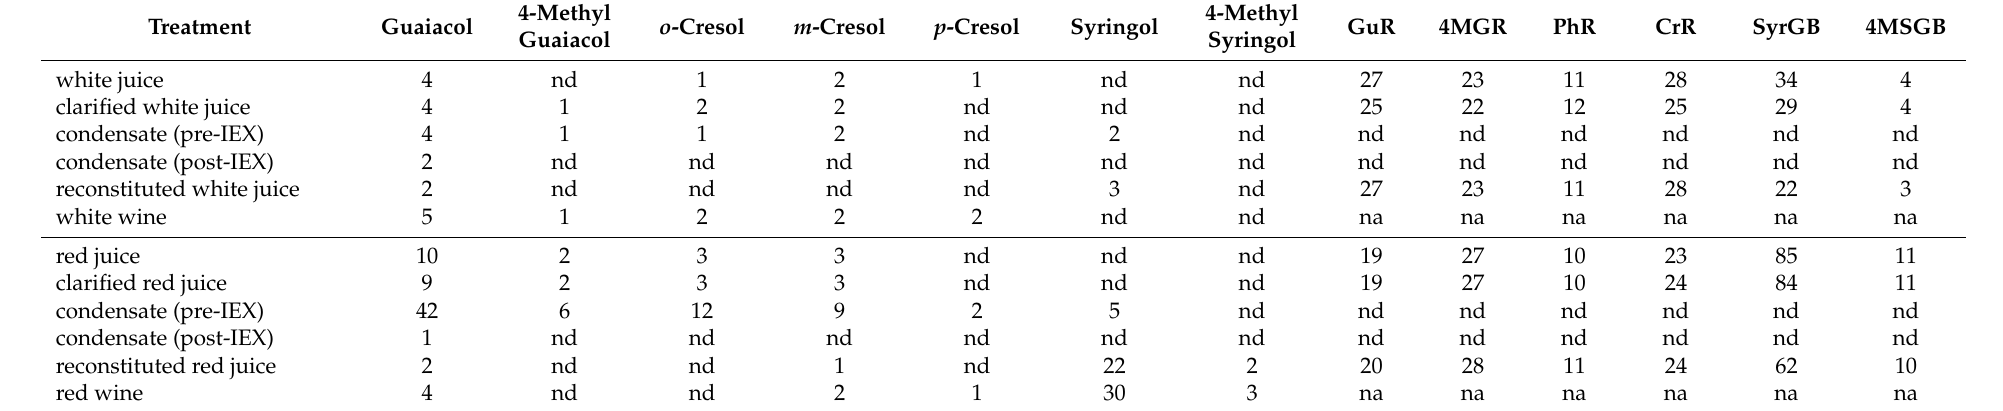
Table 3. Concentrations of volatile phenols and their glycoconjugates ( µ g/L) in samples collected during remediation of smoke-tainted white and red juice. Treatment